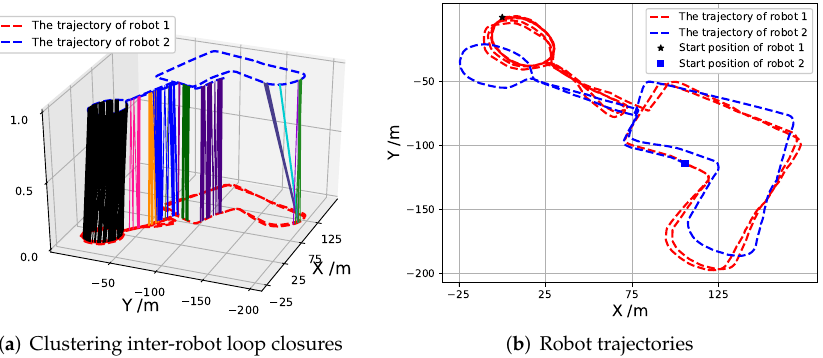
Figure 1. ( a ) Clusters consist of topologically related measurements and are labeled by different colors. ( b ) Two sets of robot trajectories, the blue square represents the end position of trajectory 1, which is also the start position of trajectory